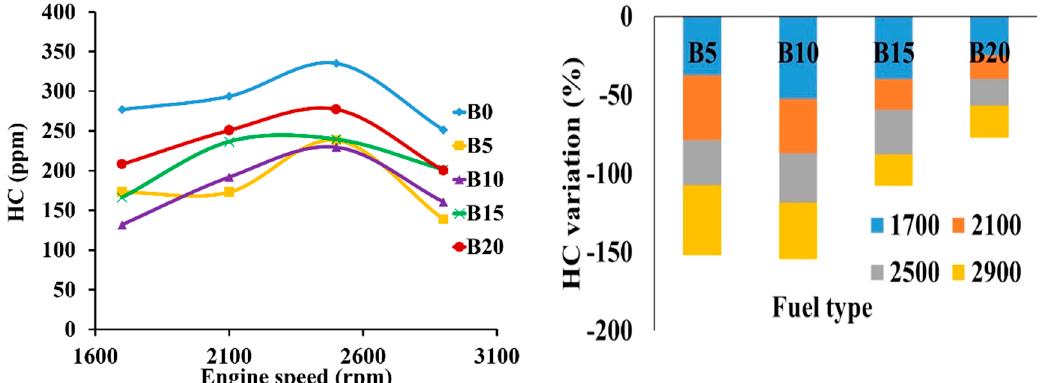
Figure 15. Variation of HC (ppm) for different engine speeds and diesel biodiesel blends at full load.